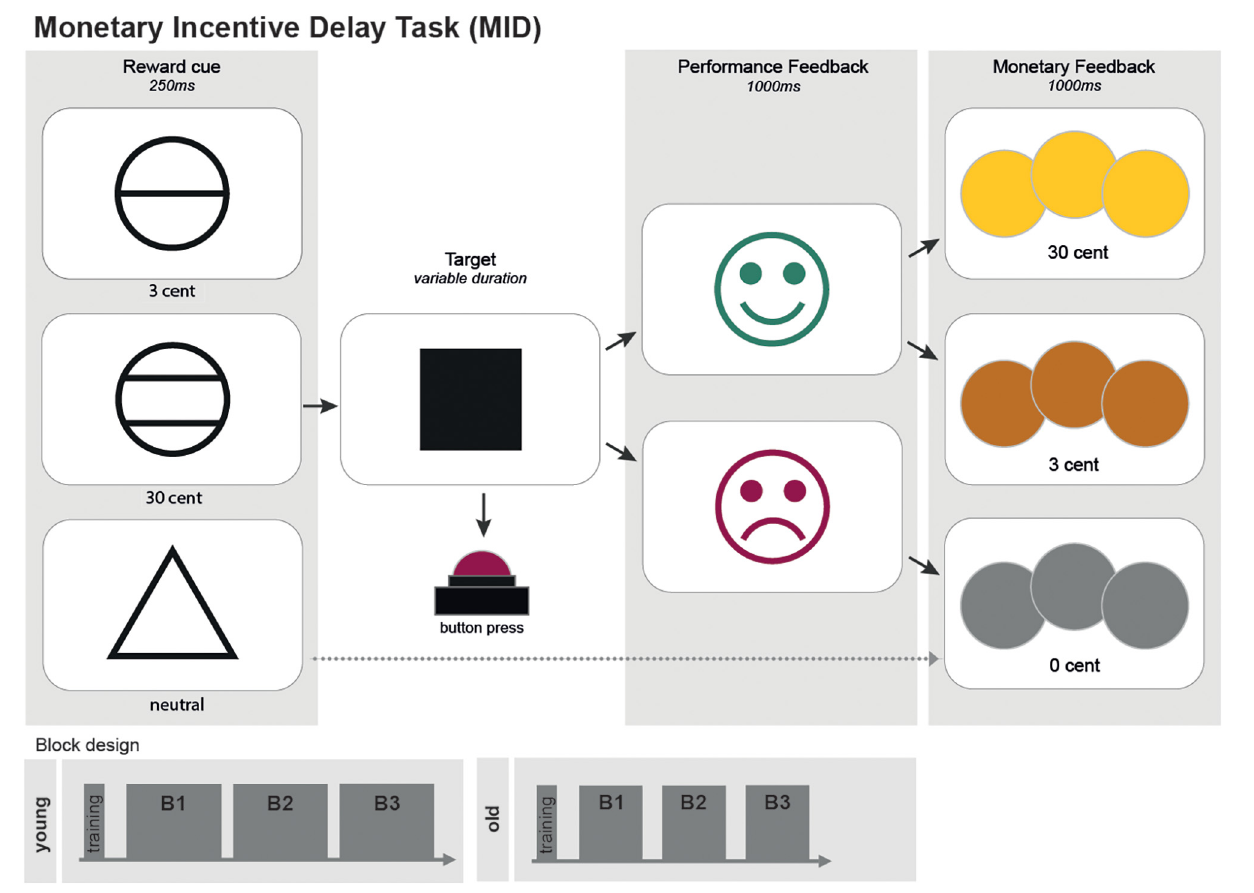
FIGURE 1 | A scheme of the monetary incentive delay task (MID). The MID consisted of 450 trials (300 trials for the older group) separated into three blocks. Each trial randomly started with one of the three following reward incentive cues: a circle with one line indicated a possible gain of 3 cents; a circle with two lines, indicating a possible gain of 30 cents; and a triangle, indicating a possible gain of 0 cent. The cues were shown for 250 ms each. The trials cued with a triangle (0 cent-gain) served as the neutral control condition. Between the cue and the target, a fixation cross with randomized duration (750-1,250 ms) was presented. Target duration was adapted to individual reaction times, resulting in a predestined hit rate of 75%. Performance feedback was presented by a green laughing smiley if the time limit was not exceeded. A red sad smiley appeared otherwise. Afterward, pictures of coins visualized monetary rewards. Both feedback screens had duration of 1,000 ms